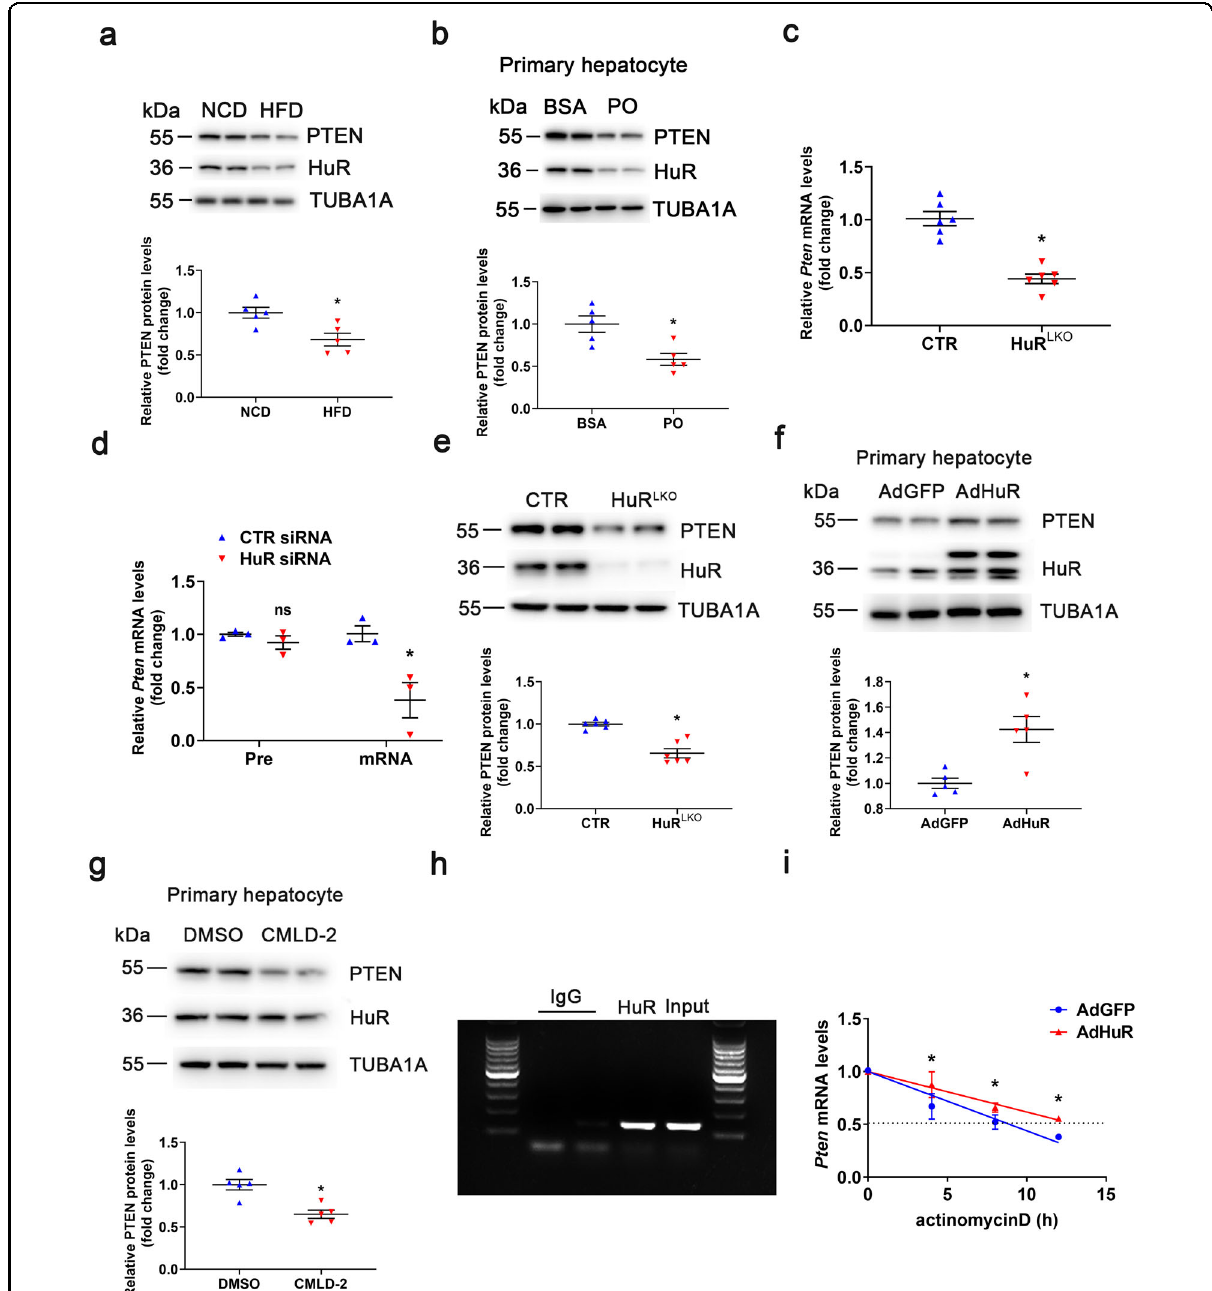
Fig. 5 HuR regulates Pten mRNA stability. a Western blot analysis of PTEN protein levels in livers of NCD- or HFD-fed CTR and HuR LKO mice ( n = 5). * P < 0.05 vs NCD. b Western blot analysis of PTEN protein levels in primary hepatocytes stimulated with BSA or PO for 24 h ( n = 5). * P < 0.05 PO vs BSA. c qPCR analysis to detect Pten mRNA levels in liver of CTR and HuR LKO mice ( n = 5). * P < 0.05 vs CTR. d qPCR analysis to detect Pten pre-mRNA and mature mRNA levels in primary hepatocytes transfected with CTR siRNA or HuR siRNA ( n = 3). * P < 0.05 vs CTR siRNA. e Western blot analysis of PTEN protein levels in the liver of CTR and HuR LKO mice ( n = 5). * P < 0.05 vs CTR. f Western blot analysis of PTEN protein levels in primary hepatocytes infected with adenovirus expressing GFP or HuR for 24 h ( n = 5). * P < 0.05 vs AdGFP. g Primary hepatocytes were stimulated with DMSO or CMLD-2 (30 μ M) for 24 h. Western blot analysis of PTEN protein levels and quanti fi cation ( n = 5). * P < 0.05 vs DMSO. h RNA immunoprecipitation with anti-HuR antibody or control IgG. i Primary hepatocytes infected with adenovirus expressing GFP or HuR for 24 h were stimulated with 10 μ g/mL actinomycin D for the indicated time. qPCR analysis of Pten mRNA levels ( n = 3). * P < 0.05 vs AdGFP.